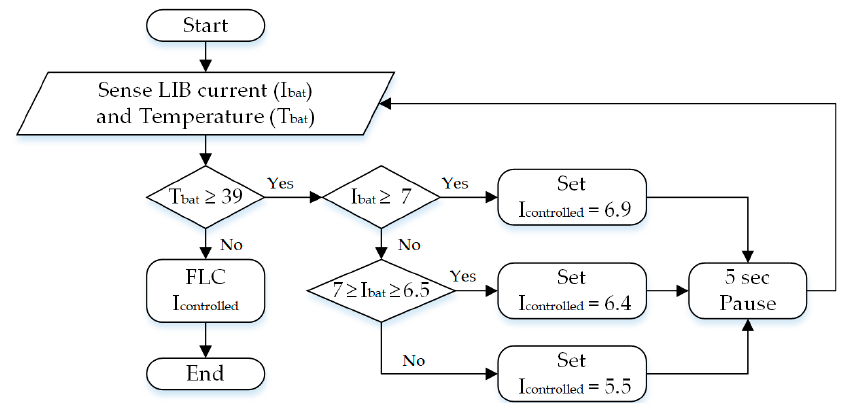
Figure 3. Flowchart for temperature control.